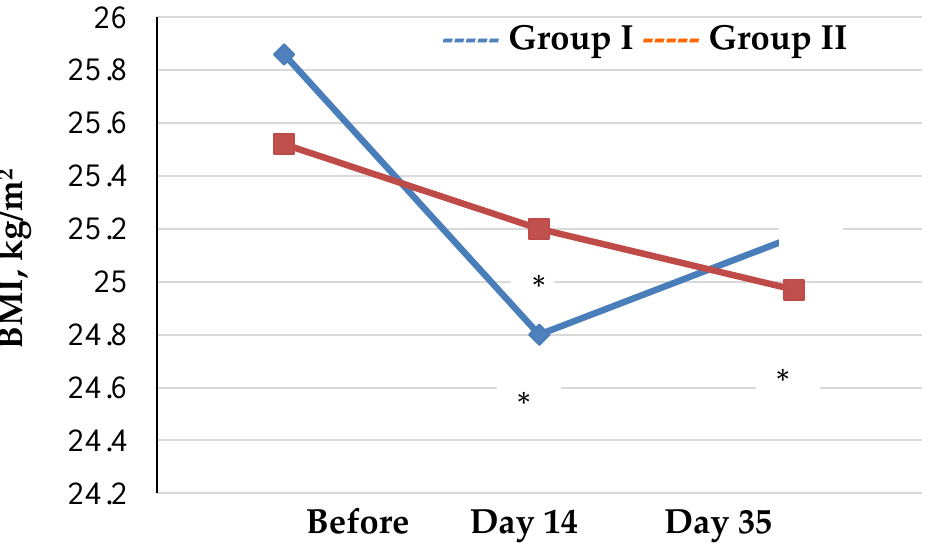
Figure 2. Trends in BMI values of athletes by group (* p < 0.05—statistical significance of differences compared to the baseline).